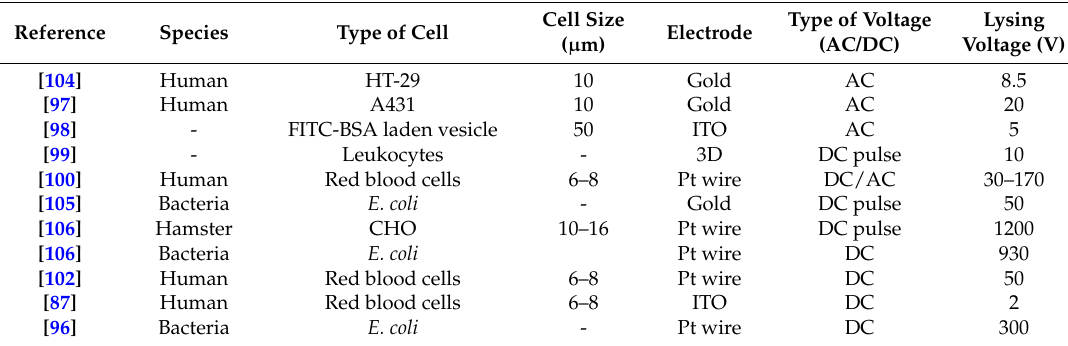
Table 4. Different electrical lysis devices used for cell lysis.